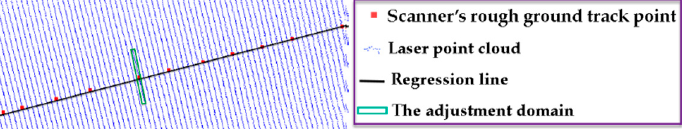
Figure 9. Smooth line operation of scanner’s estimated ground tracks.